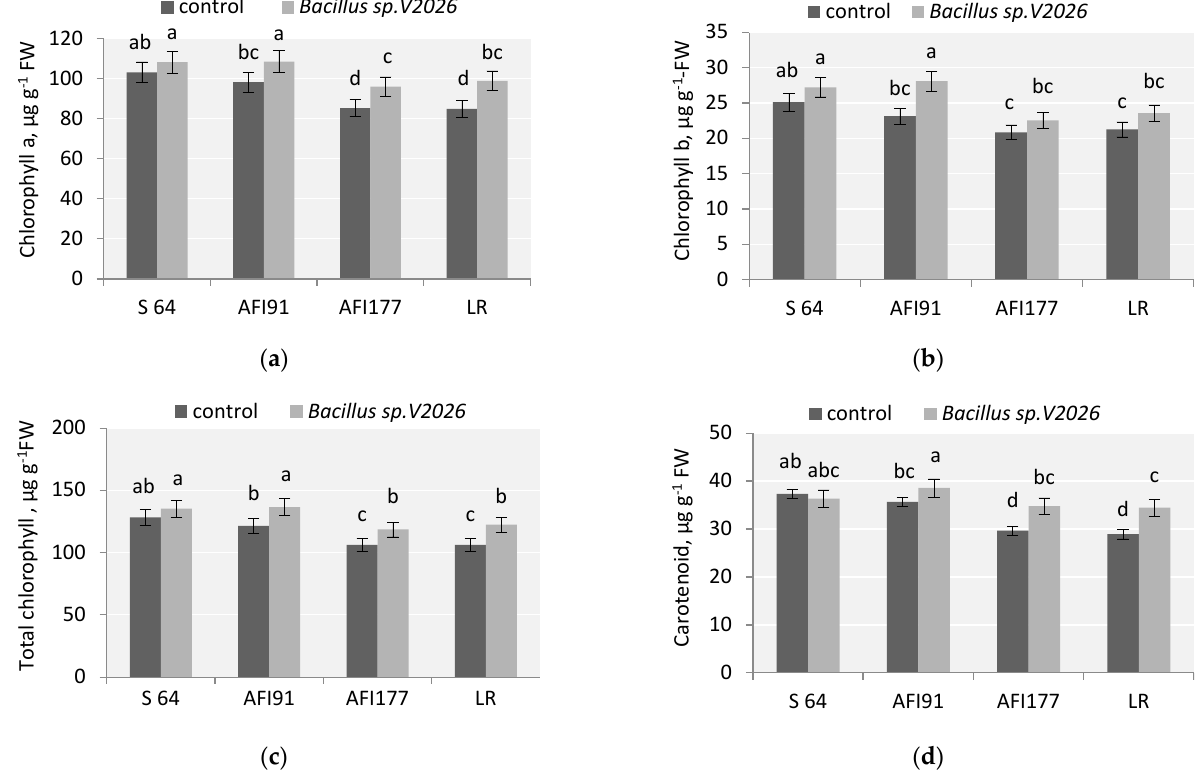
Figure 3. Effect of Bacillus sp . V2026 on chlorophyll a ( a ), chlorophyll b ( b ), total chlorophyll ( c ), and carotenoid ( d ) content of early-maturing wheat plants grown under hydroponic conditions. Bars with different letters are significantly different at p ≤ 0.05, as determined by Duncan’s multiple range test.